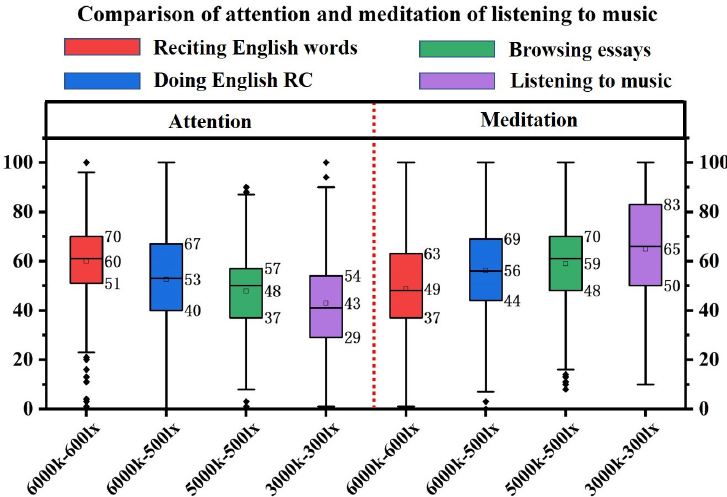
Figure 22. Box plot: Comparison of attention and meditation of listening to